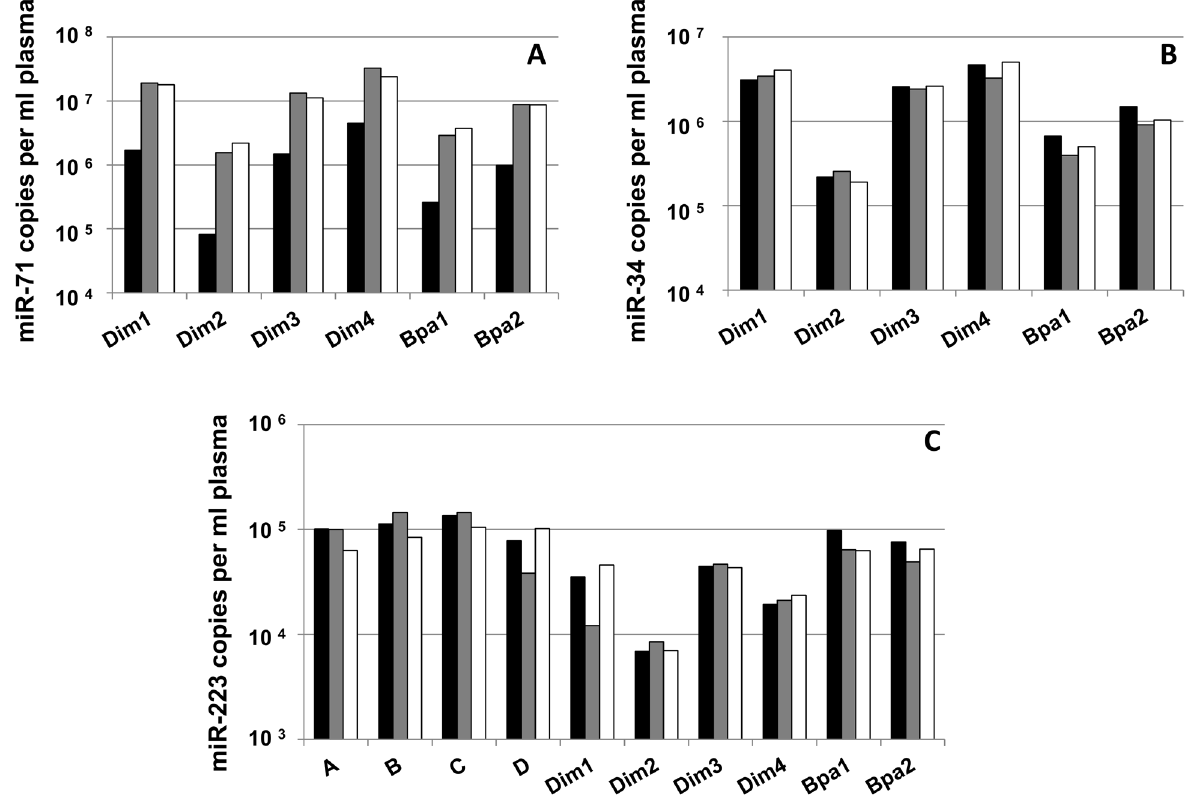
Figure 1. Extrapolated absolute miRNA copy number per ml plasma, from 3 independent RT-qPCR experiments. A: miR-71, only D. immitis and B. pahangi -infected samples; B: miR-34, only D. immitis and B. pahangi -infected samples; C: miR-223, all samples. Uninfected dogs=samples A–D. Black bars=experiment 1; gray bars=experiment 2; white bars=experiment 3.